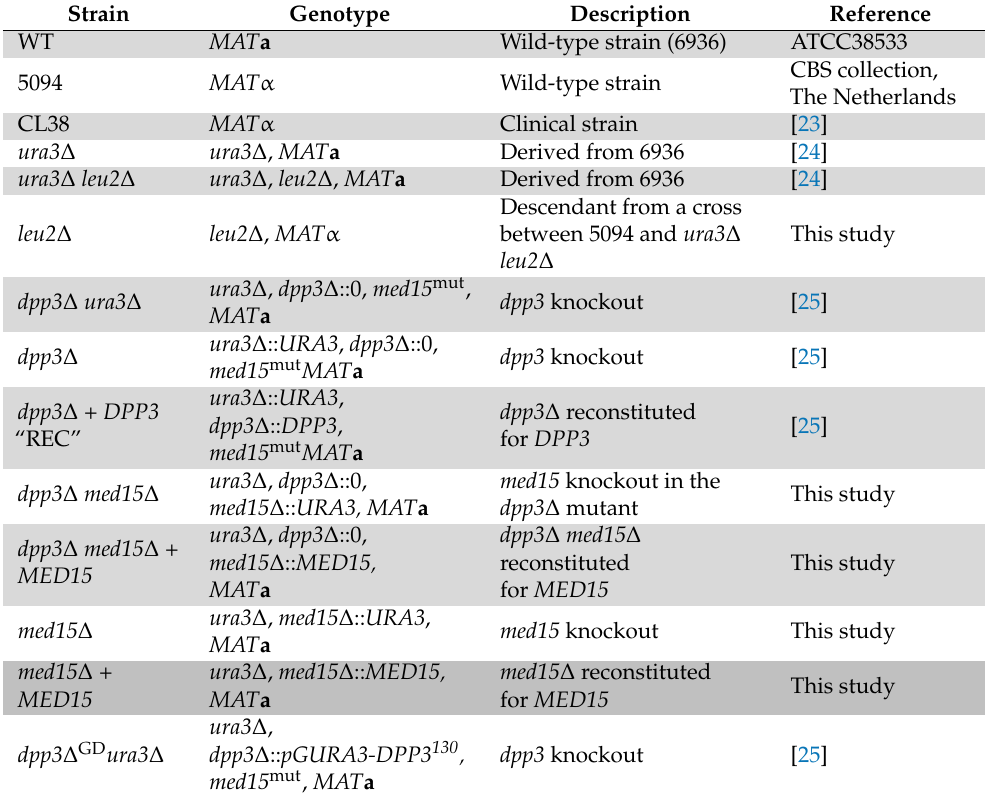
Table 1. C. lusitaniae strains used in this